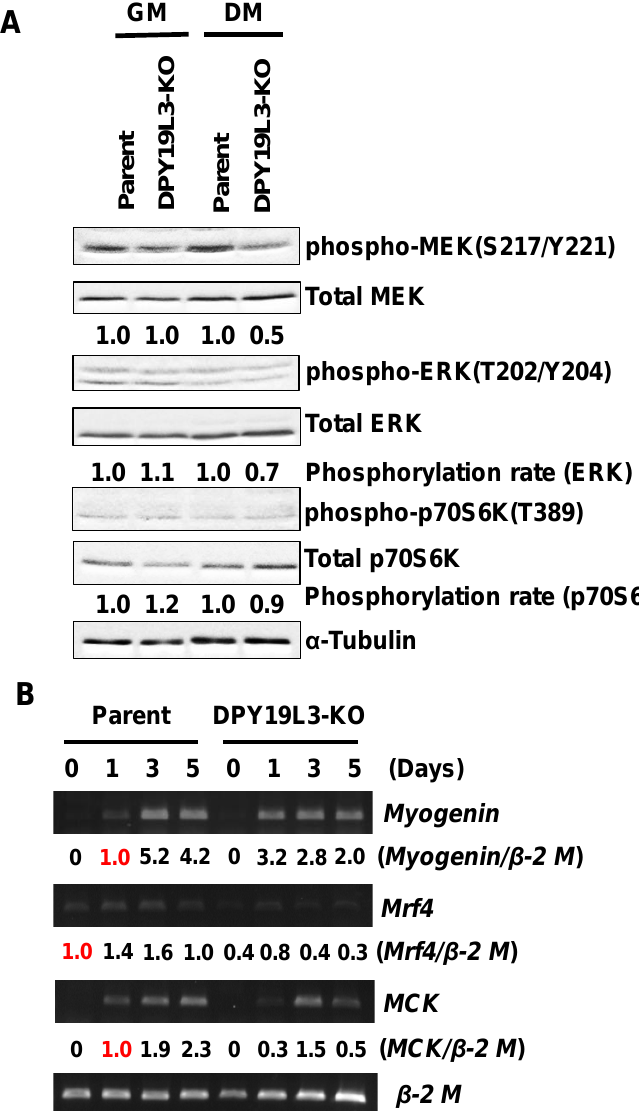
Figure 4. Suppression of phosphorylation levels of MEK, ERK, and p70S6K in C2C12-DPY19L3-KO cells. ( A ) C2C12 (parent) and C2C12-DPY19L3-KO (DPY19L3-KO) cells were cultured in GM or in DM for 5 days. The cells were lysed, and immunoblotting was performed with the indicated antibodies. Phosphorylation levels of MEK, ERK, and p70S6K were normalized by Total MEK/ERK/p70S6K, then GM and DM parent cells were defined as 1.0, respectively. ( B ) C2C12 (parent) and C2C12-DPY19L3-KO (DPY19L3-KO) cells were cultured in GM or in DM for 5 days. Total RNAs were isolated, and expression levels of myogenin, mrf4, MCK, and β-2 microglobulin ( β-2 M ) were determined by semi-quantitative RT-PCR. Signal intensities of myogenin , mrf4 , and MCK were quantified, and normalized to β-2 M. Red 1.0 meant the samples used for definition.